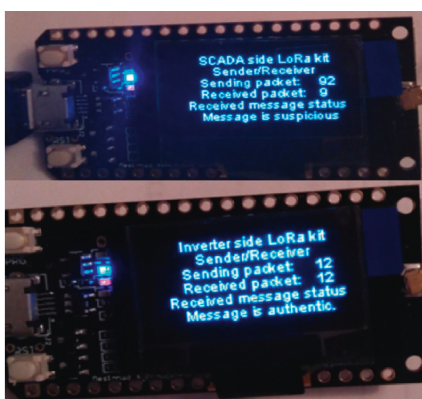
Figure 7: Configuring ESP32-LoRa sender and receiver at different